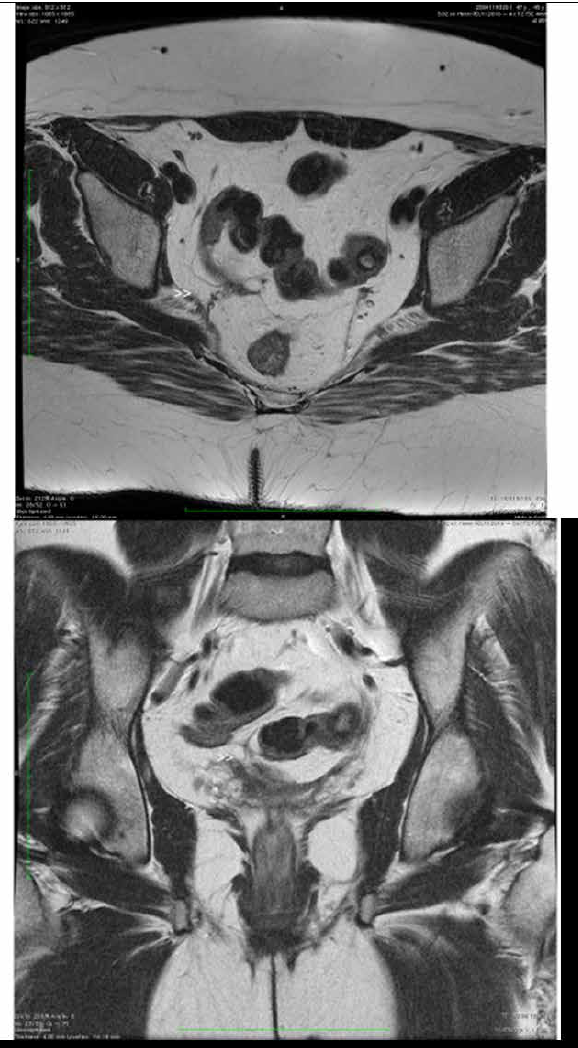
Figure. 1: Abdomen- Pelvic MRI . Fibrotic abnormalities, with preva- lence lamellar, that branch off on the right from the vaginal hemicu- pole, from which they reach the right ureter in the pre-bladder tract adhering to the posterior wall of the